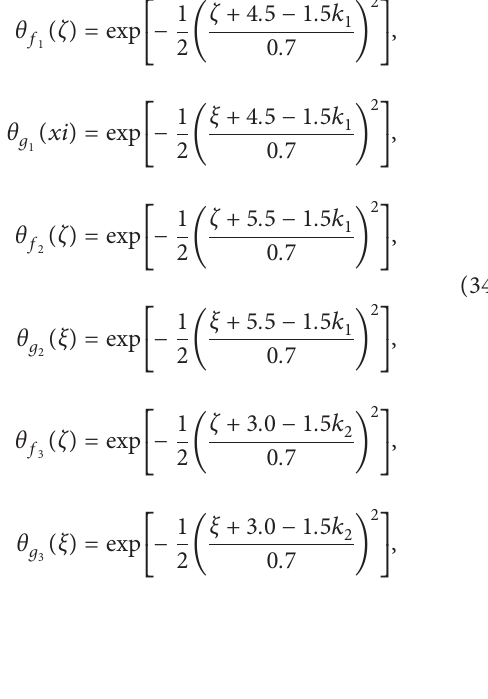
, e ,e by method (35) in time period (a) [0, 10s] and (b) [5 s, 1 2 3